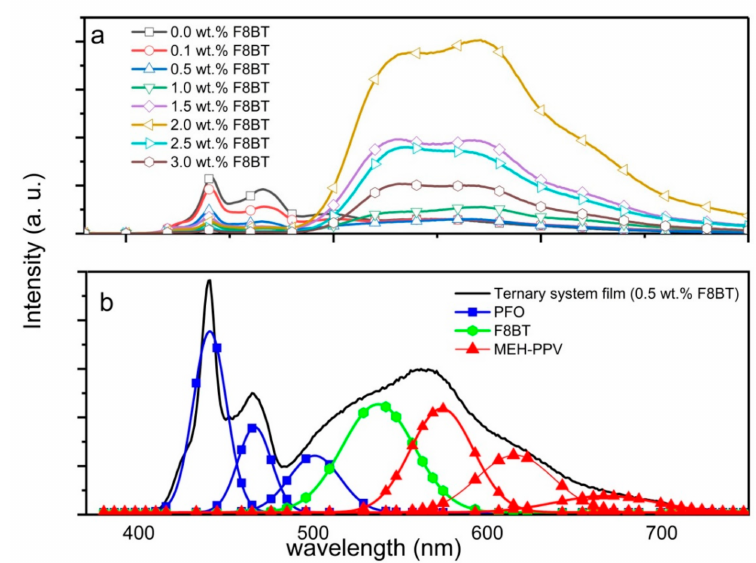
Figure 4. ( a ) Emission spectra of PFO / F8BT / 0.3 wt.% MEH-PPV ternary blend thin films with di ff erent wt.% of F8BT; ( b ) Gaussian deconvolution of the emission spectrum from PFO / 0.5 wt.% F8BT / 0.3 wt.% MEH-PPV ternary blend thin